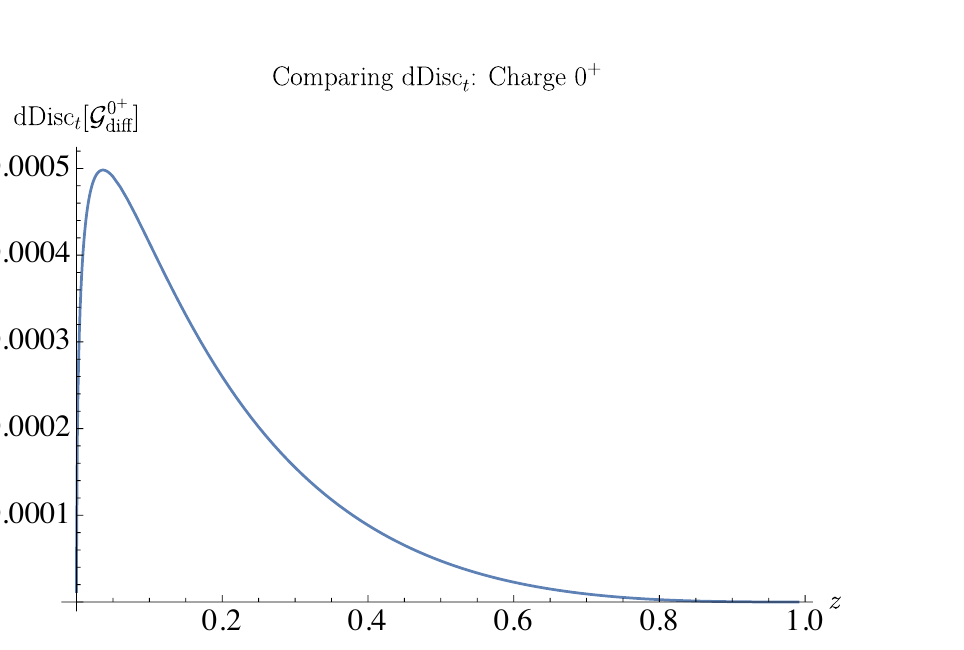
( z; z )] and see that norm